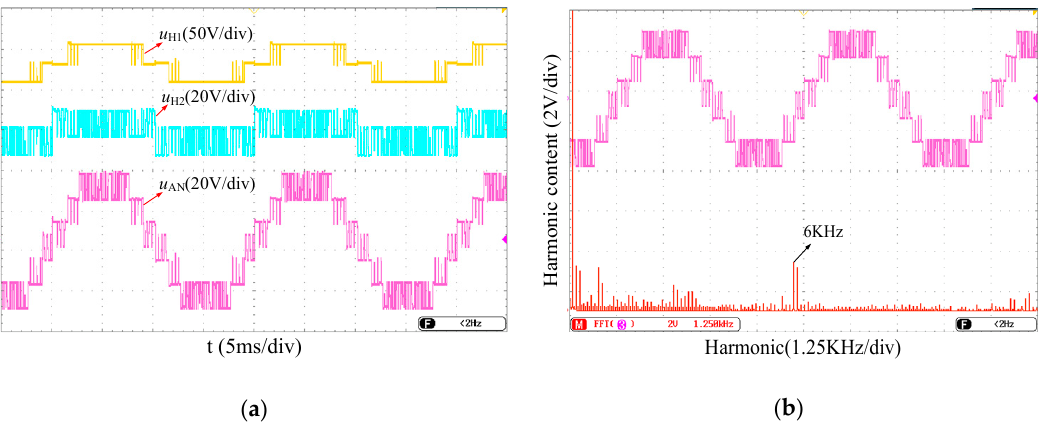
Figure 14. Experiment result (m = 0.9, frl = 3 KHz). ( a ) Output voltage of each unit in two cycles. ( b ) Phase voltage spectrum.